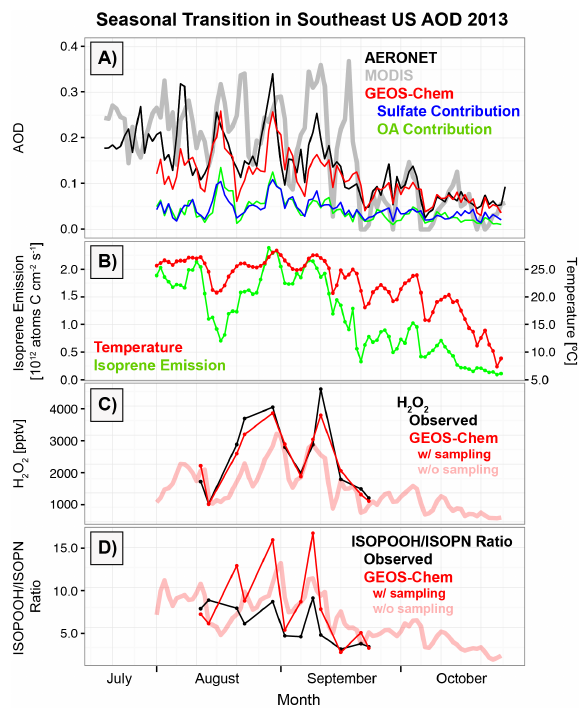
Figure 11. Seasonal transition of aerosol optical depth (AOD) and related variables over the southeast US in August–October 2013. (a) AODs measured by MODIS and AERONET, and GEOS- Chem values sampled at AERONET times and locations with sim- ulated contributions from sulfate and OA. (b) 24-hour average MEGAN2.1 isoprene emissions and GEOS-FP surface air temper- atures. (c) H 2 O 2 concentrations measured from the aircraft below 1km altitude and simulated by GEOS-Chem sampled at the times and locations of the observations. Each data point represents the median value over the southeast US for an individual flight. GEOS- Chem H 2 O 2 concentrations averaged over the entire region (i.e., without sampling along the flight tracks) are shown separately and extend into October. (d) Same as (c) but for the molar ratio of isoprene peroxides (ISOPOOH) to isoprene nitrates (ISOPN). The southeast US domain is as defined in Fig.